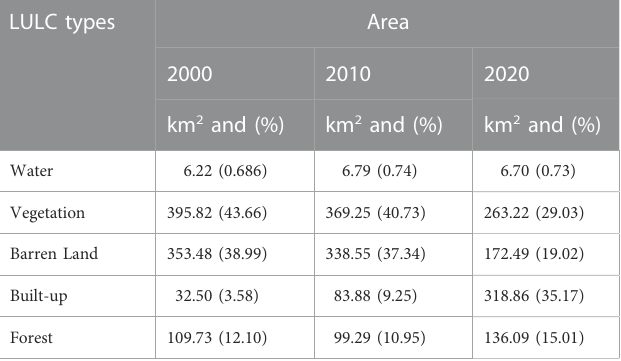
TABLE 2 Land use and land cover pattern changes from 2000 to 2020.